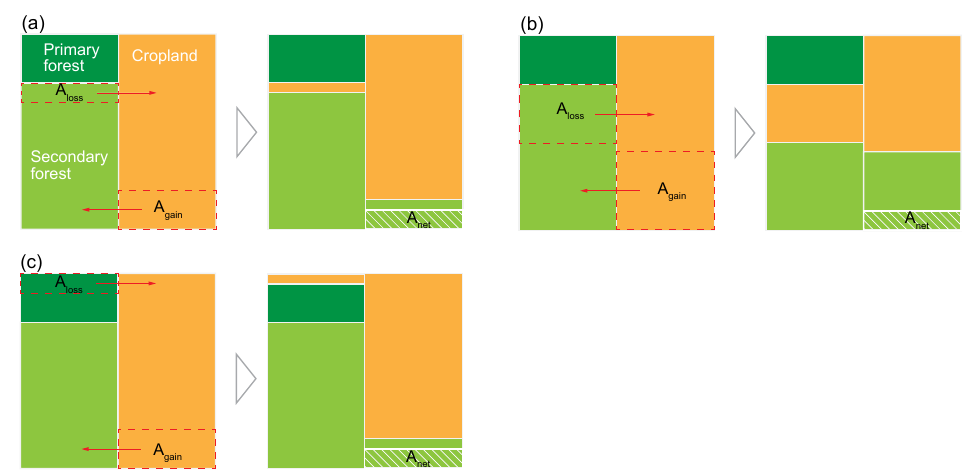
Figure 2. An illustration of different gross forest area changes with the same net area change. (a) Net forest gain with small gross secondary forest area changes (secondary to secondary), thus low γ area changes (secondary to secondary), thus high γ instead of gross secondary